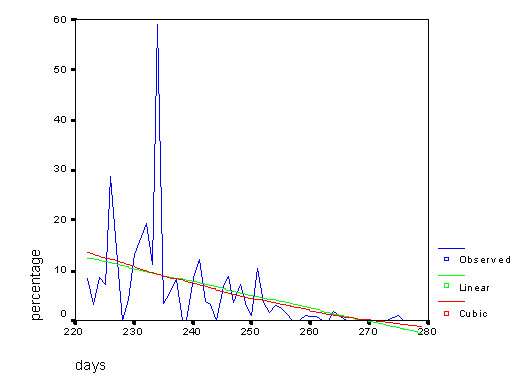
Distribution and regression of the percentage of unsatisfactory inspection results of premises inspected outside the Olympic Venues 160 days before the end of the Olympics, r = 0.44, p < 0.0001.